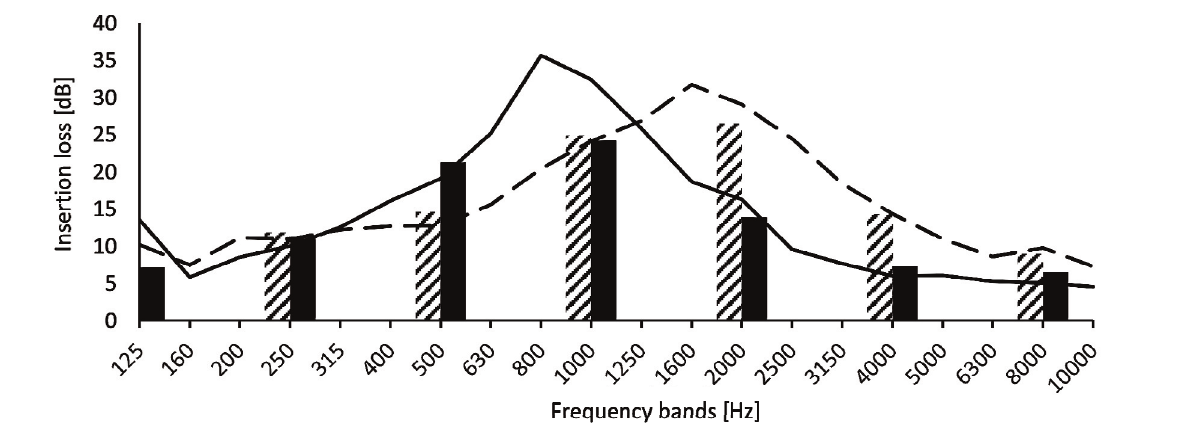
Fig. 19. Insertion loss of the silencer prototype in 1/1 octave band (lines) and in 1/3 octave band (vertical columns) compared to the average of commercially available HVAC silencer selected for reference. Insertion loss of the proposed silencer prototype (solid line, black columns) compared with the reference units (dashed line, hatched